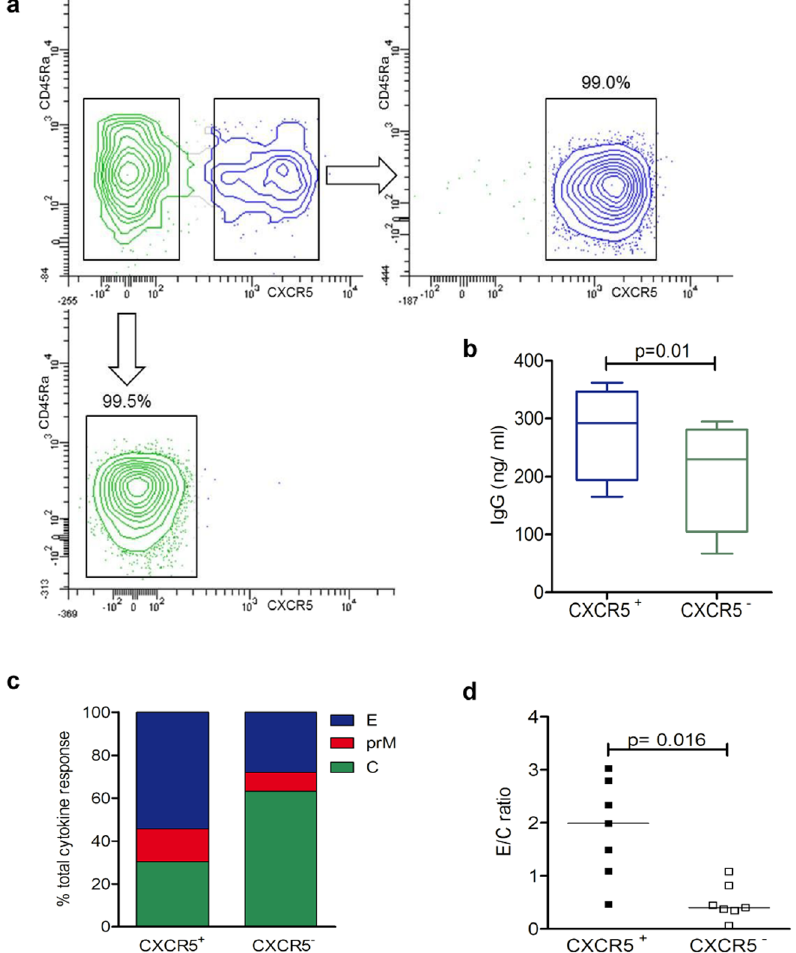
Figure 2. CXCR5 + and CXCR5 − CD4 T cell response to YF virus C, prM and E peptides. ( a ) CD4 + CD45Ra − memory T cells from PBMC of healthy donors were sorted into CXCR5 + (upper right) and CXCR5 − cells (lower left). ( b ) IgG concentration revealed by ELISA in supernatants of sorted autologous B cells cultured for 10 days with either CXCR5 + or CXCR5 − cells in 4 independent experiments. Statistical signifiance was determined with the two-way ANOVA. ( c ) Percentage of cytokine events in sorted CXCR5 + and CXCR5 − subsets contributed by C, prM and E peptides as determined by intracellular cytokine staining. ( d ) Ratios of results with E and C peptides obtained in individual donors. Statistical signifiance was determined with the Wilcoxon matched-pairs signed rank